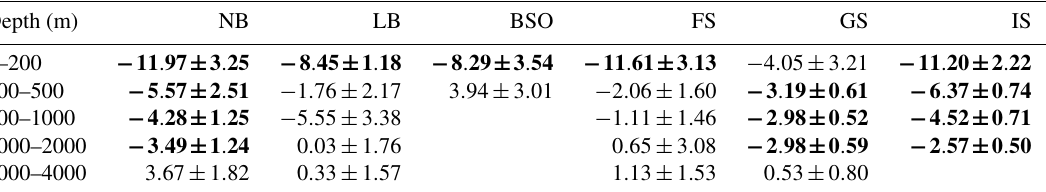
Table 5. (cid:127) Ar trends ± standard error (10 − 3 yr − 1 ), calculated from the data presented in Fig. 8, in the Norwegian Basin (NB), Lofoten Basin (LB), Barents Sea Opening (BSO), Fram Strait (FS), Greenland Sea (GS), and Iceland Sea (IS; Fig. 1). Bold numbers indicate that the trends are significantly different from zero.